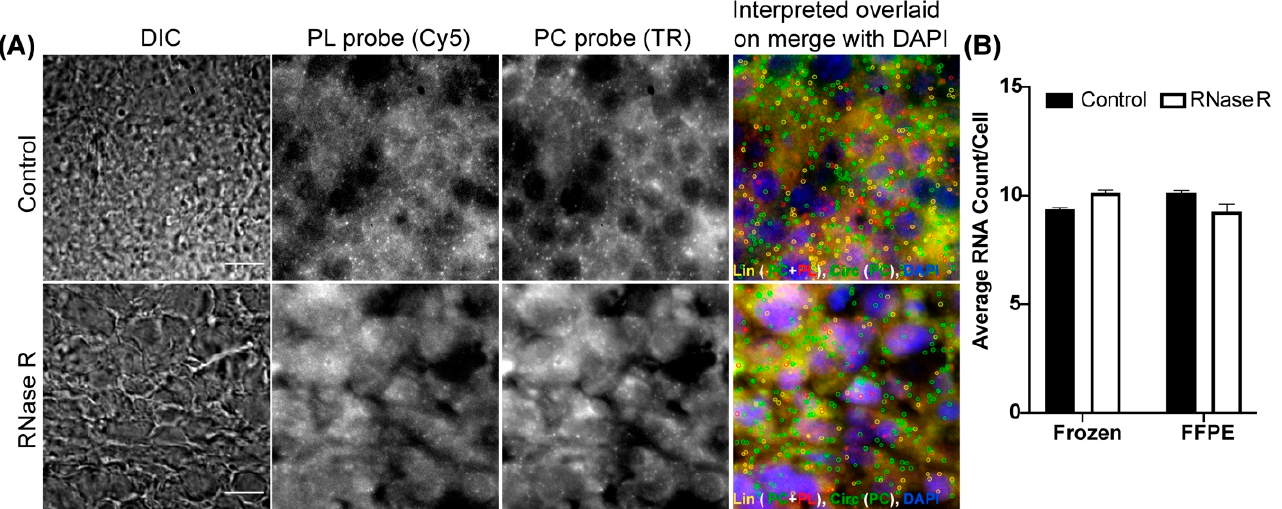
Figure 6. Visualizing circPOK in frozen and FFPE mouse tissues using circFISH. ( A ) Representative image panel of frozen mouse melanoma tissue with (labeled as RNase R) or without (labeled as Control) 2 h RNase R treatment before the PL and PC probe hybridization. Columns from the left: DIC; raw merged z stacks of cells for PL probes labeled with Cy5; raw merged z stacks of cells for PC probes labeled with TR; and a merged image of the two channels with TR spots pseudo-colored green and Cy5 pseudo-colored red, overlaid on DAPI with MATLAB-interpreted spots showing the linear and circular RNAs as yellow or green spots, respectively. ( B ) Quantification of the circPOK RNA per cell in frozen and FFPE mouse tissue samples between the control and RNase R-treated samples. The error bars indicate the 95% confidence interval. At least 100 cells were counted for each condition. The scale bar is 5 μ m.